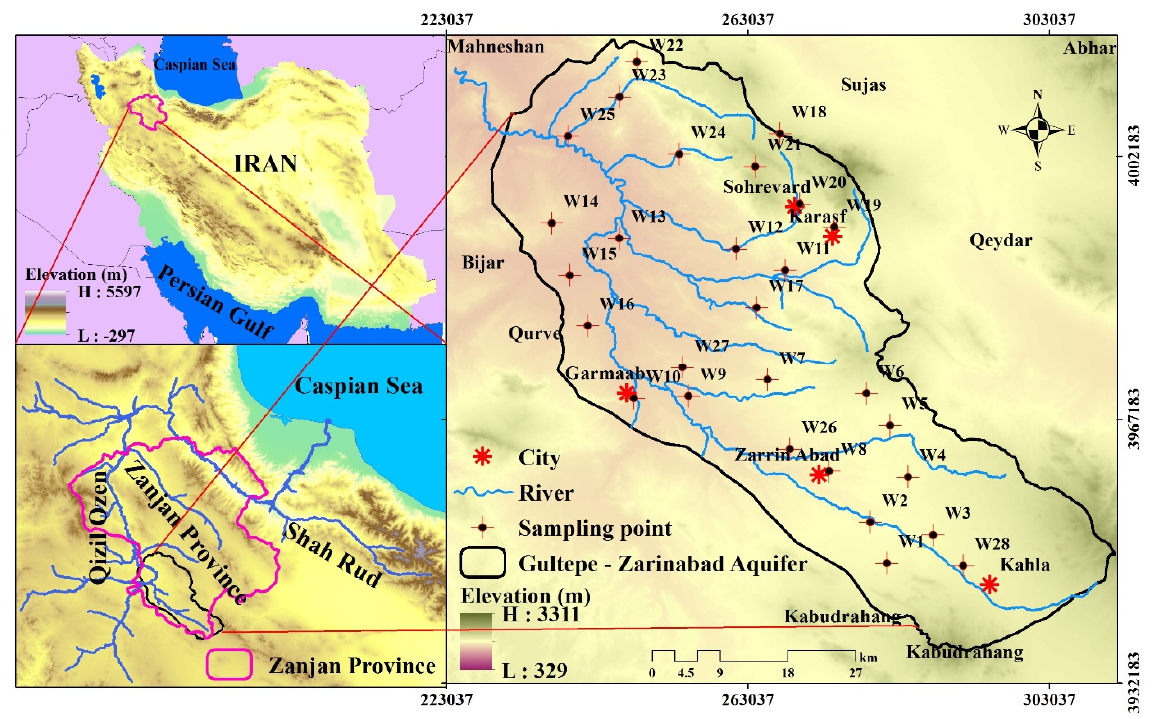
Figure 1. Location map of the study area and groundwater sampling sites.